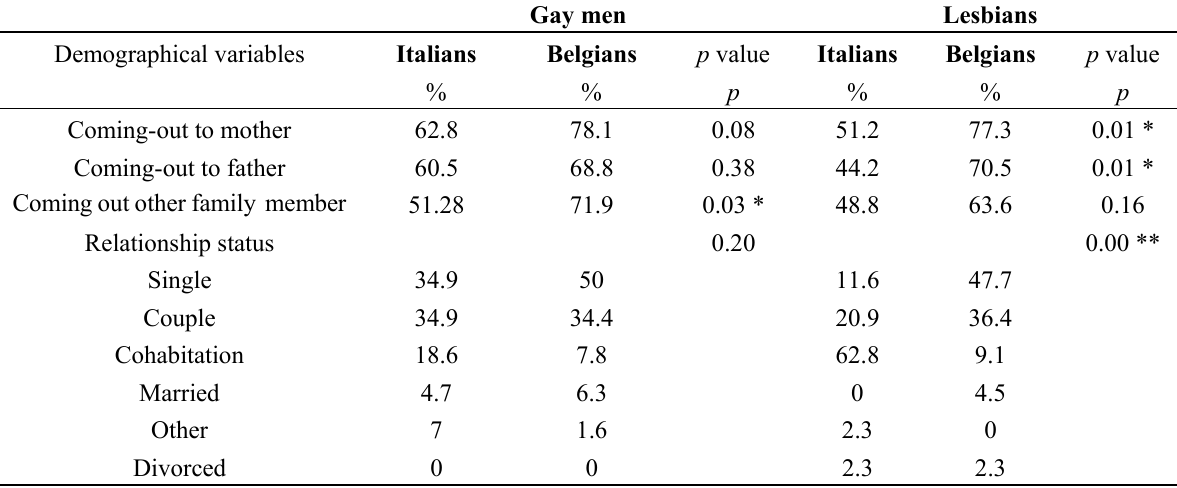
Table 2. Percent frequencies and significances regarding demographic